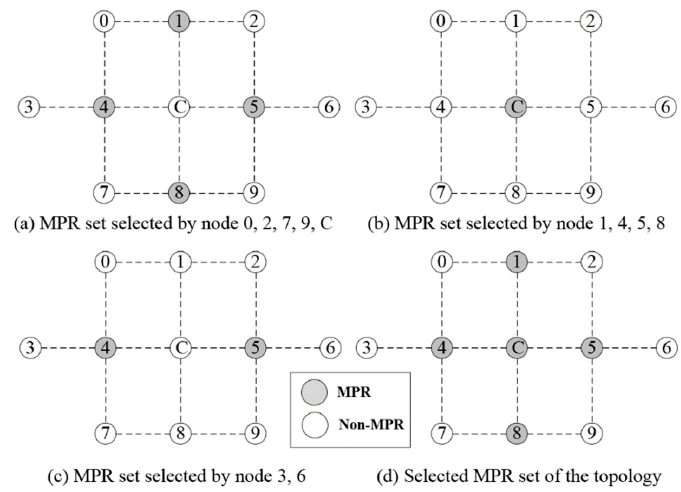
Figure 5. An example of Multiple Point Relay (MPR) selection for reducing packet flooding of the